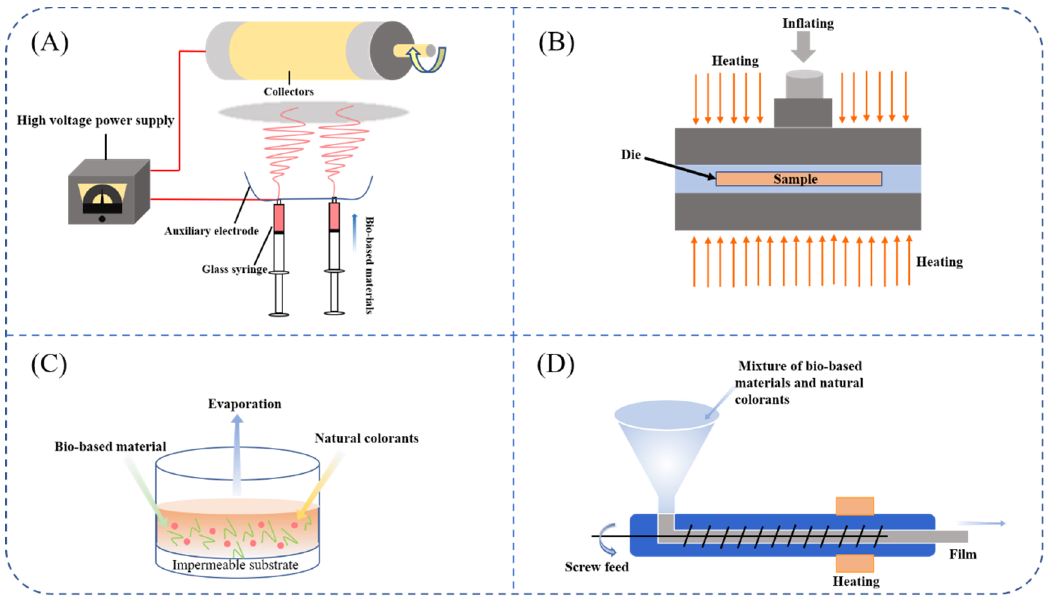
Figure 3. The preparation methods for freshness indicators: ( A ) electrospinning; ( B ) compression molding; ( C ) solvent casting; ( D ) extrusion. Table 1. Methods of developing pH-responsive freshness